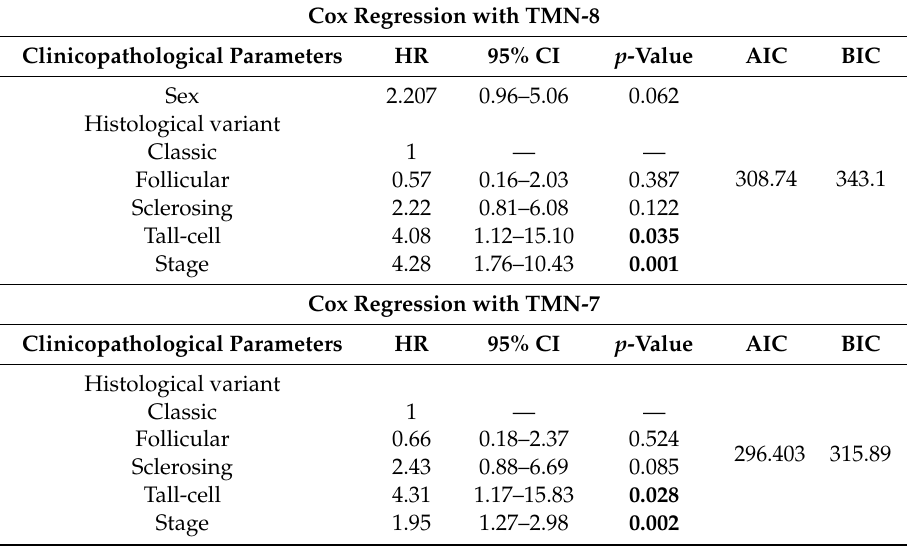
Table 2. Cox regression for the prediction of DFI was performed with stage and other clinicopathological parameters. The table shows predictors retained in the model after backward selection. The variables entered in the analysis were: gender, histological variants, AITD, multifocality, stage (8th or 7th edition), capsular, muscle, and vascular invasion. HR: hazard ratio. CI: confidence interval. AIC: Akaike information criterion. BIC: Bayesian information criterion. p -values < 0.05 are evidenced in bold. Cox Regression with